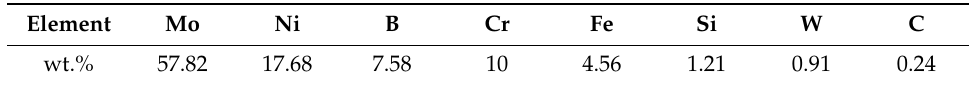
Table 1. Composition of the powder.